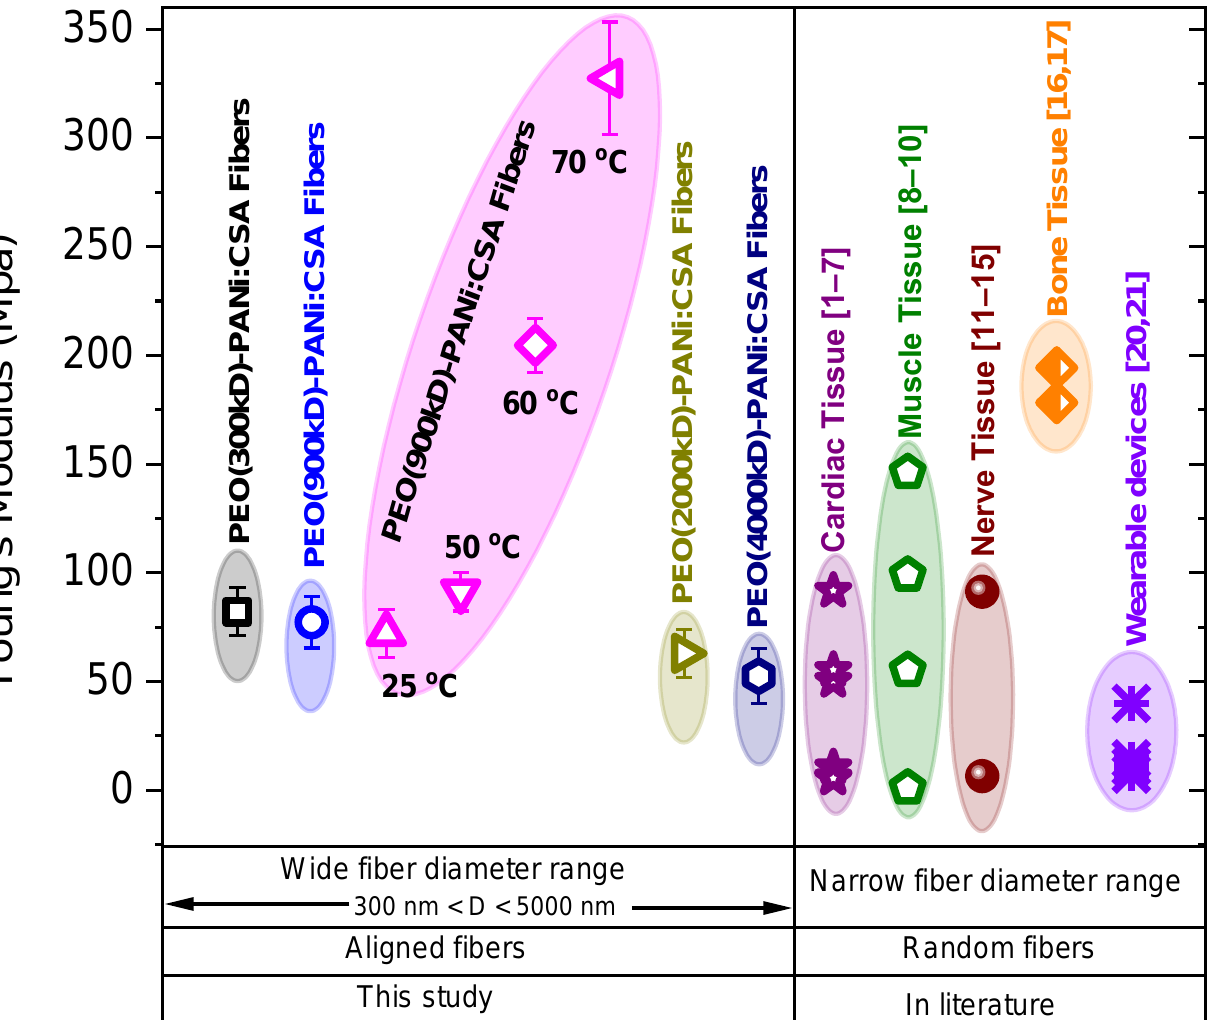
Figure 11. The comparison of Young’s moduli of conductive fibers in this study (PEO-PANi:CSA fibers with 300 kD–4000 kD molar mass of PEO) and stated in the literature for various biomedical applications. The PEO (900 kD)-PANi:CSA fibers were annealed at 50, 60, and 70 °C for 24 h.